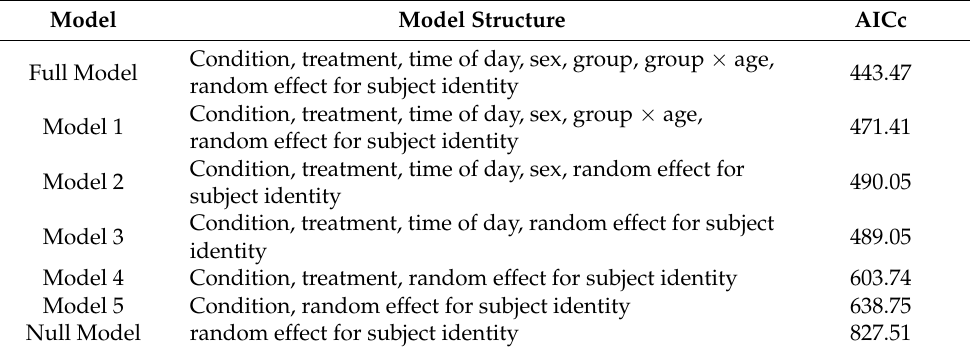
Table 9. Model structures and AIC values obtained during model selection for behavioural compe-